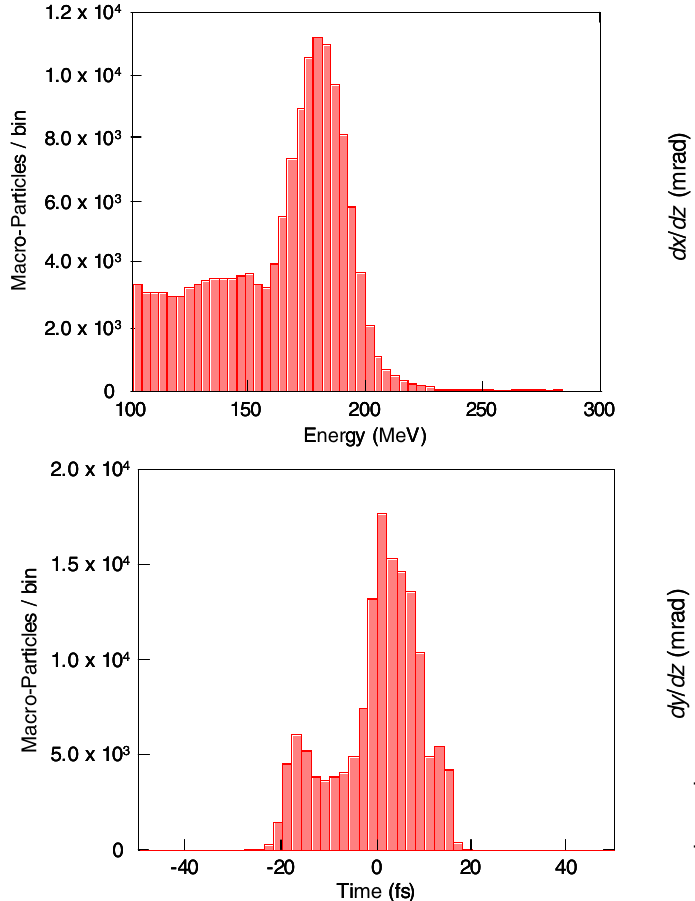
FIG. 3. (Color) LWFA transverse electron beam phase space, as simulated by 3D PIC